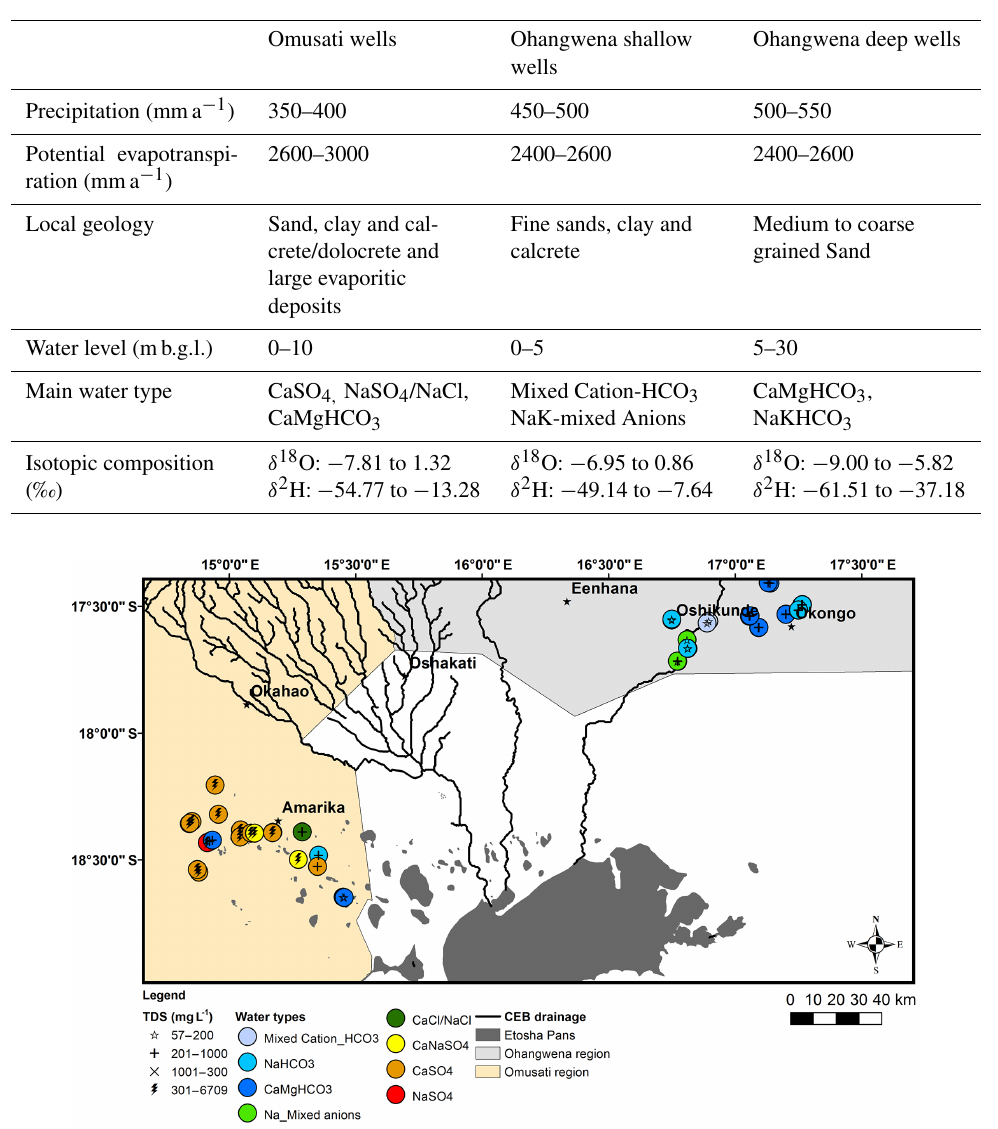
Figure 2. Spatial distribution of TDS and water types in the study